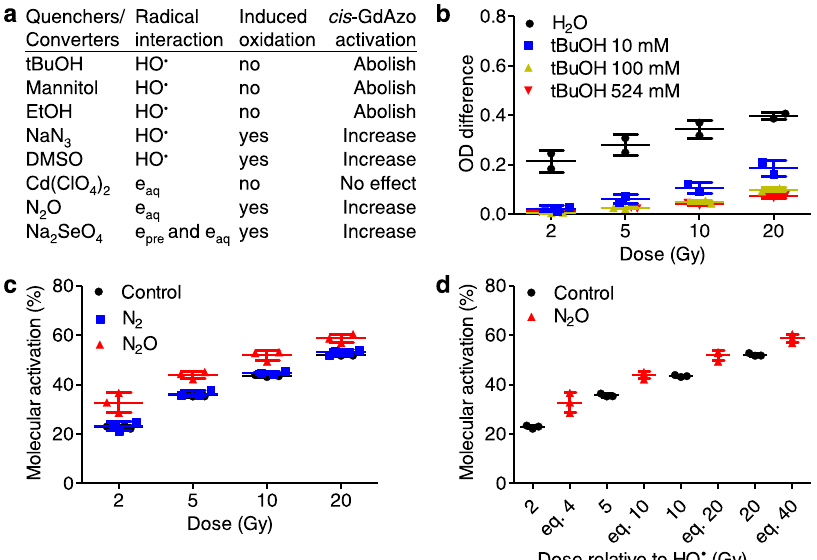
Fig. 4 Investigation on activation mechanism using scavengers. a Quenchers and converters used to highlight the impact of speci fi c radicals on cis - GdAzo -activation ef fi cacy upon XR, GR and E (cf. Supplementary Section 7 for details). b Absorbance difference (365 nm) of medium containing cis - GdAzo (50 µ M) in the presence of tBuOH (10, 100, 524 mM ( ∼ 5% v/v), control in water) before and after GR irradiation ( n = 2 independent experiments). c Molecular activation of cis - GdAzo (50 µ M, H 2 O) upon GR irradiation in N 2 or N 2 O-saturated solutions (Control without inerting) determined by HPLC and reported as the difference of trans -isomer proportion before and after GR irradiation ( n = 3 independent experiments). d Comparison of cis - GdAzo activations in control (no inerting) and N 2 O-saturated solutions in conjunction with the equivalent (eq.) amount of hydroxyl radicals HO (cid:129) generated depending on doses ( “ eq 4 ” , “ eq 10 ” , “ eq 20 ” and “ eq 40 ” relate to the doses of 2, 5, 10, and 20 Gy in N 2 O saturated solutions) ( n = 3 independent experiments). The means ± standard deviations are reported. OD optical